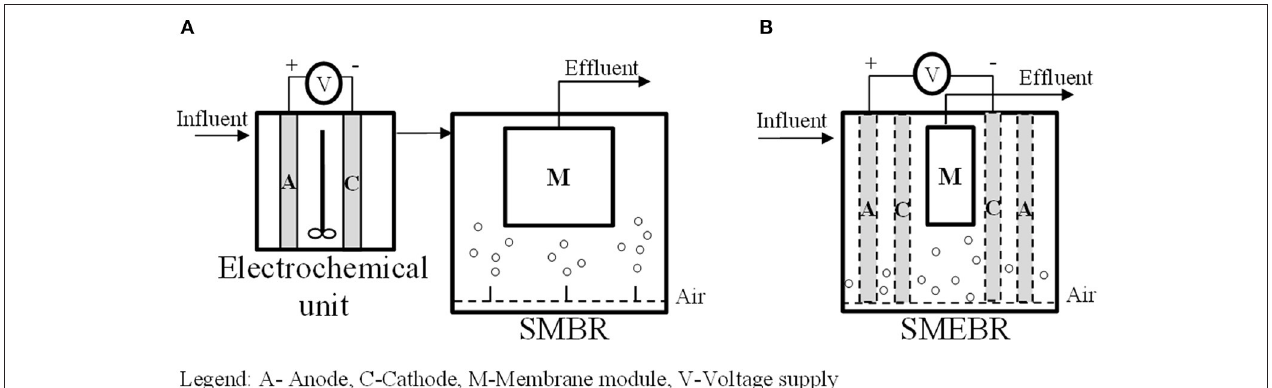
FIGURE 2 | Main eMBR configurations applied to wastewater treatment: (A) external electrochemical unit (usually electrocoagulation unit) preceding a submerged membrane bioreactor (EC-SMBR), (B) submerged membrane electro-bioreactor (SMEBR).